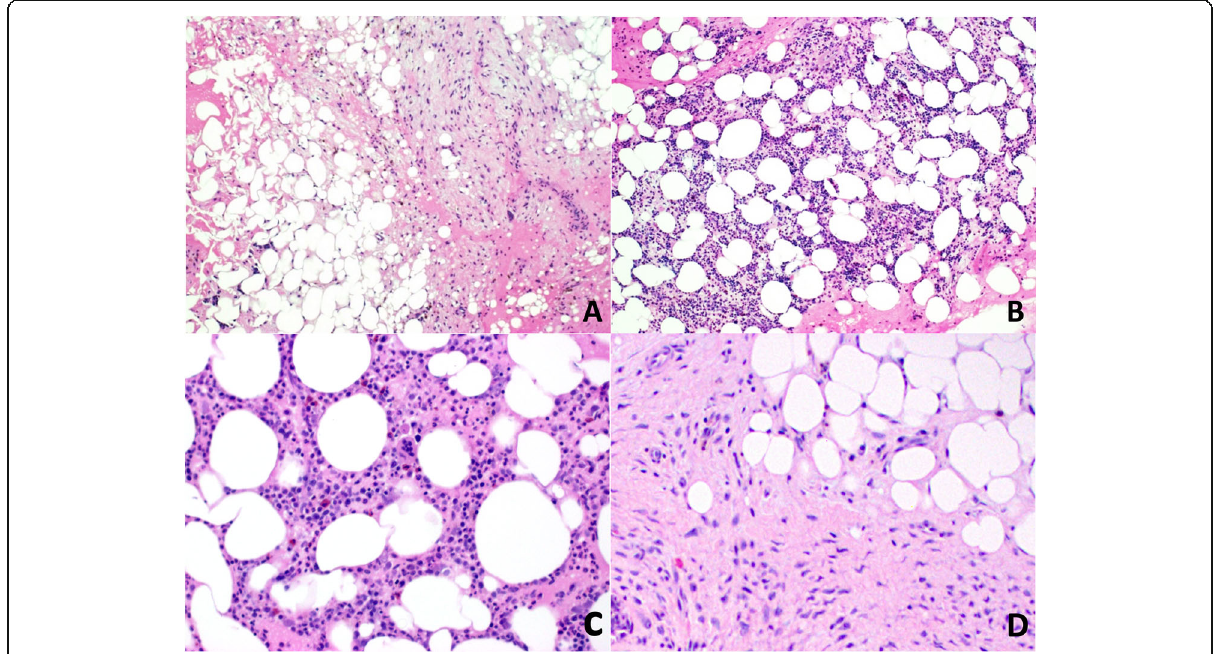
Fig. 2 Hematoxylin and Eosin staining (A: 4x10, B: 10x10, C & D: 20x10) A: Curettage sections yielded fragments of mature adipose tissue. B, C: Variable amount of normocellular mature hematopoietic cells from all three lineages are present. D: Mature adipose and fibrotic tissue is present. No osteoclastic giant cells, hemorrhage or bony tissue was